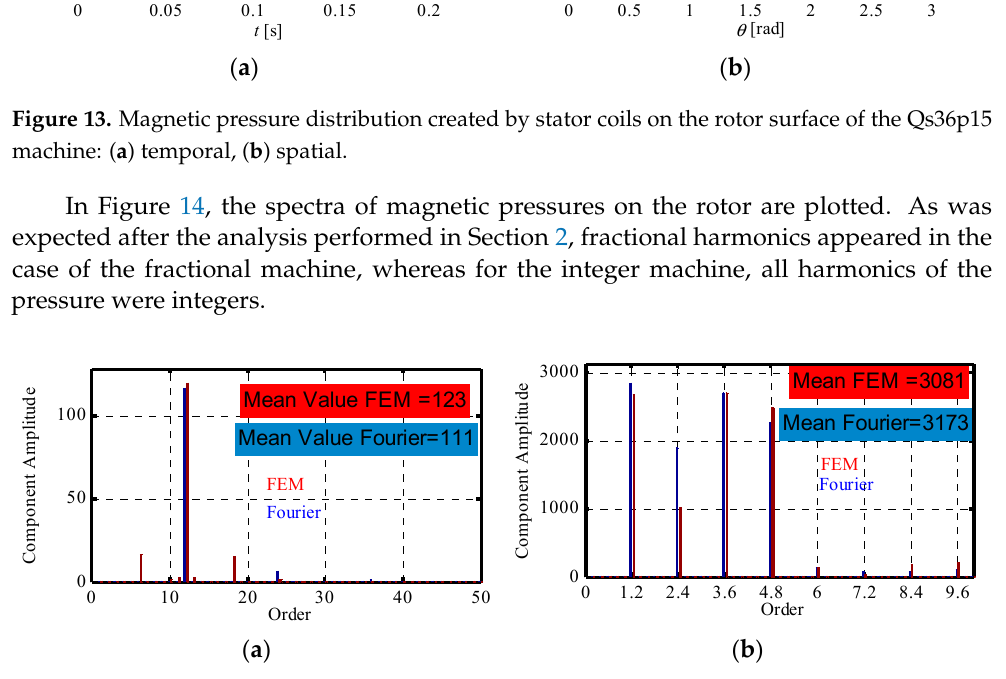
Figure 14. Spectra of magnetic pressures computed on the rotor surface: ( a ) Qs48p8, ( b ) Qs36p15.